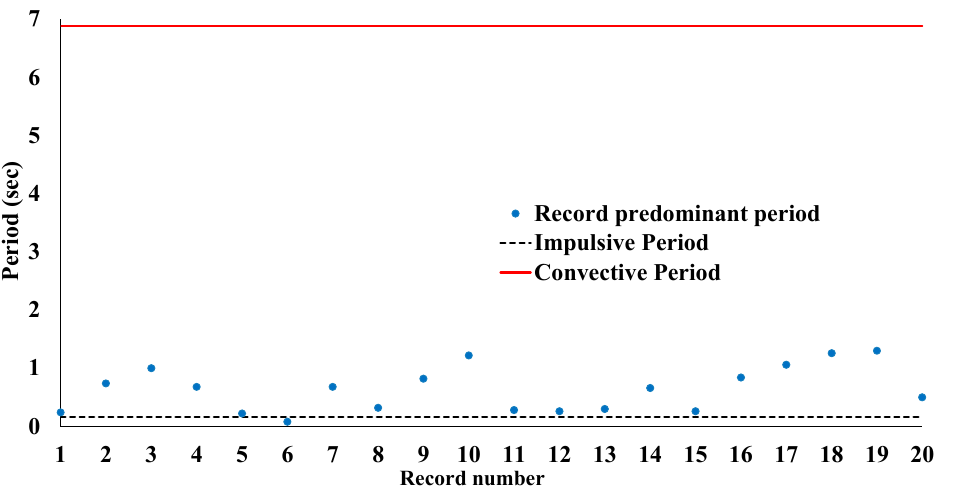
Figure 4. Predominant periods of the selected accelerograms compared to liquid content component periods (Reprinted from Computers and Structures, Volume 243, Alexandros Tsipianitis and Yiannis Tsompanakis, Optimizing the seismic response of base-isolated liquid storage tanks using swarm intelligence algorithms, Pages No. 106407, Copyright (2022), with permission from Elsevier). Table 1. Selected near-fault